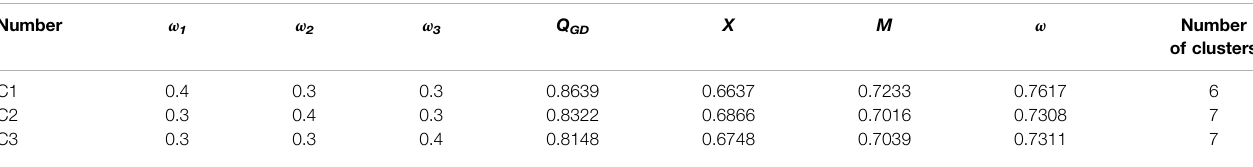
TABLE 3 | Results of cluster partition under different weight combinations.